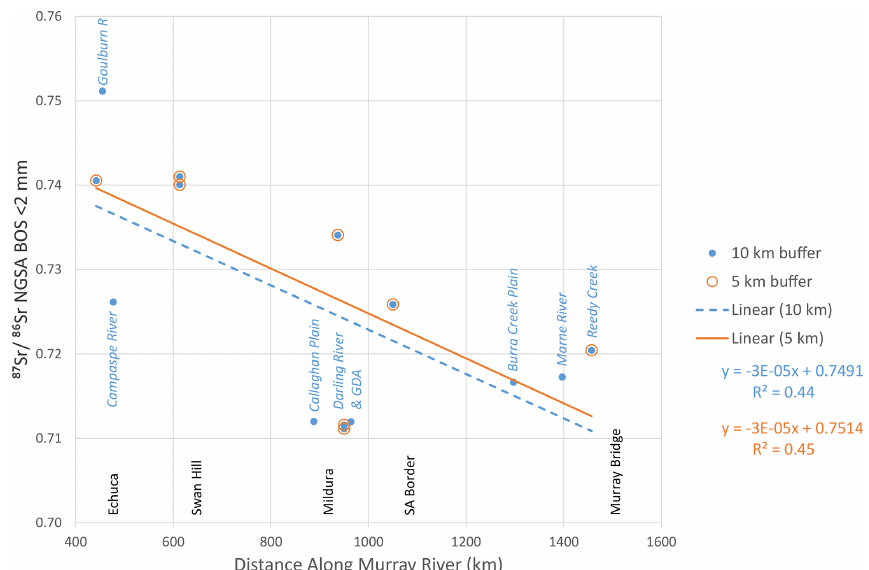
Figure 5. 87 Sr / 86 Sr profile of NGSA catchment sediment at sampling sites located within 5 and 10km buffers of the Murray River (open and closed circles, respectively) vs. downstream distance along the Murray River (east to west). Sites not directly sampling a Murray River catchment are labelled (in italics) with the name of the tributary (R = River; GDA = Great Darling Anabranch) or geomorphic entity. Least squares regression lines for the 5 and 10km buffers are shown as solid and dashed lines, respectively, and equations are given. Township and South Australia (SA) border positions are shown on the x axis.